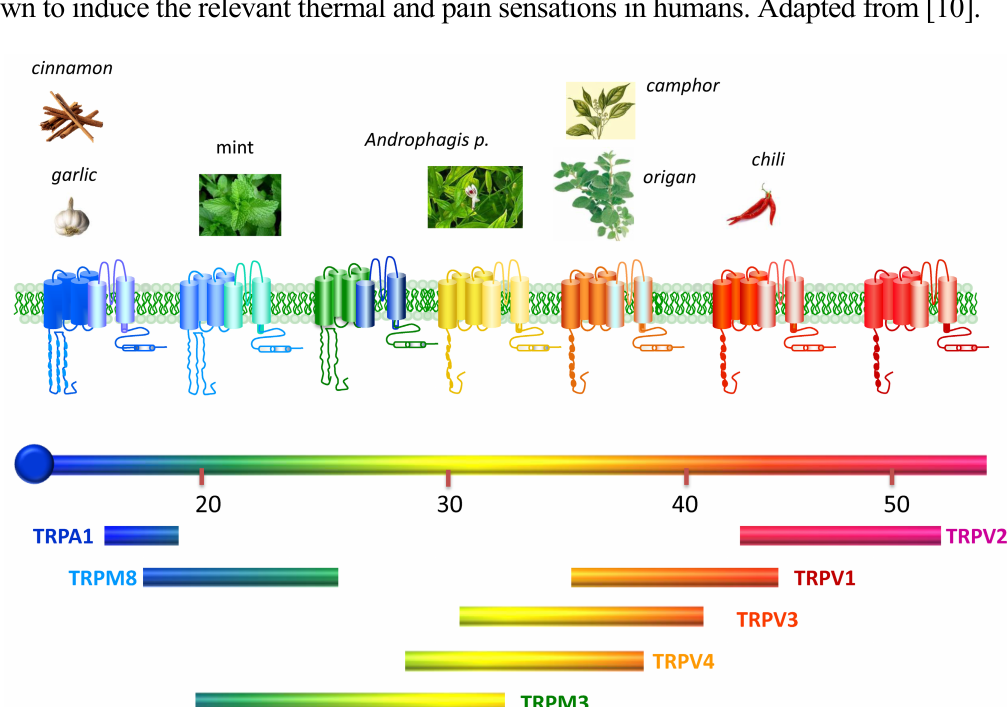
Figure 1. Thermotransient receptor potential (TRP) channels. Structurally thermoTRP are tetramers and each subunit contains six transmembrane domains (S1–S6), a hydrophobic pore loop linking transmembrane S5 and S6, and large cytoplasmic N - and C -terminals (NB not drawn to scale). All thermoTRPs have a variable number of ankyrin repeat domains in the N -terminus, except TRPM8 which has none and instead contains TRPM homology region. ThermoTRPs display distinct thermal thresholds from very noxious cold (TRPA1) to harmful hot (TRPV2). Each thermoTRP is also activated by specific natural or synthetic compounds, known to induce the relevant thermal and pain sensations in humans. Adapted from